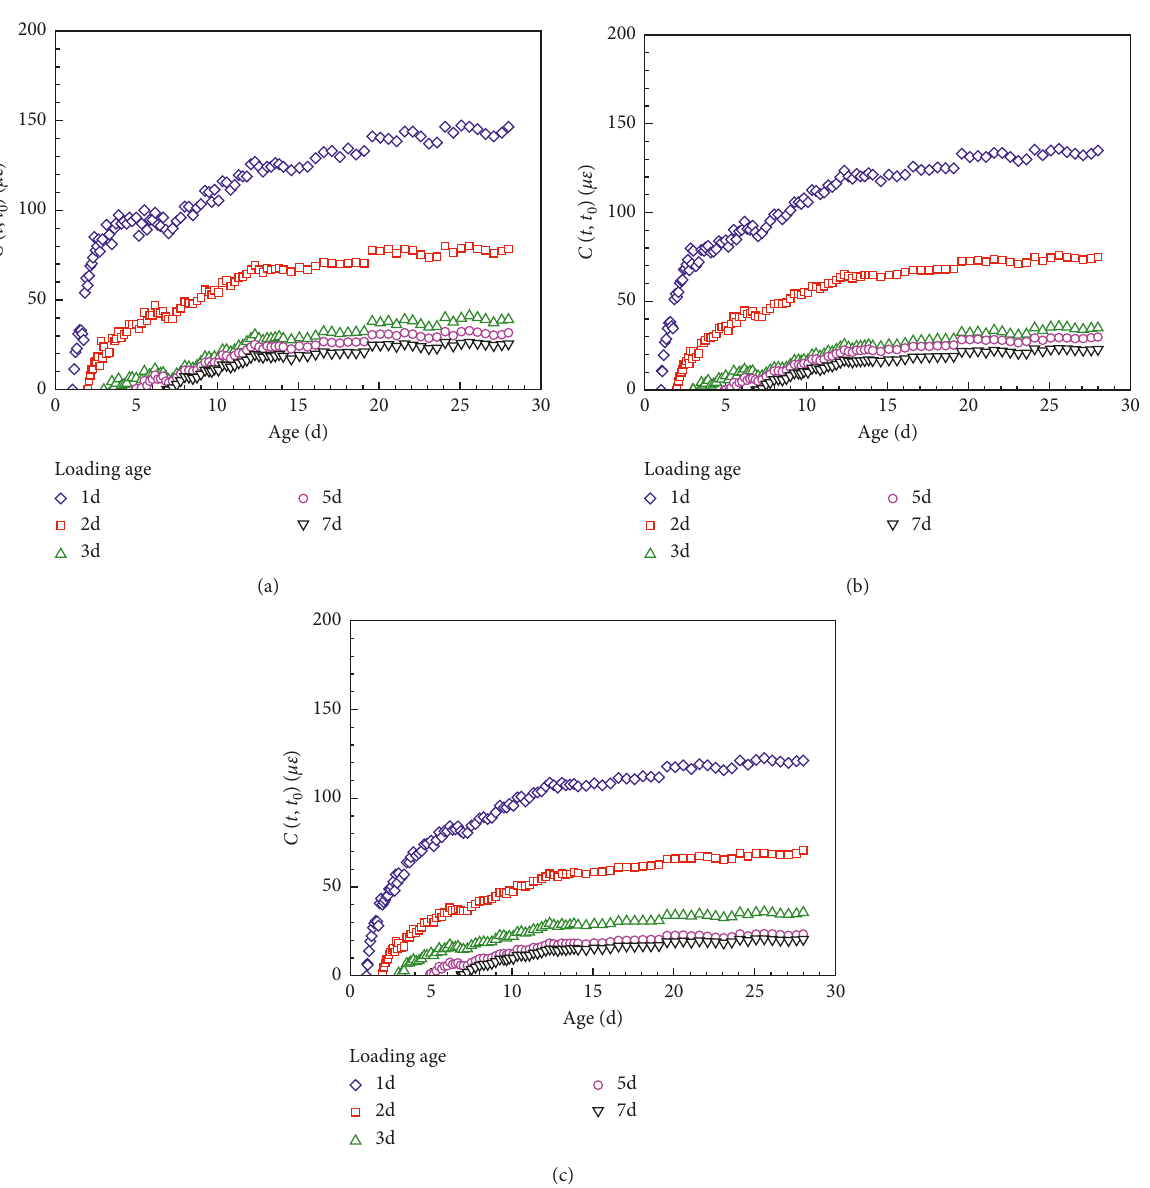
Figure 6: Specific creep of BS group at different loading ages. Stress/strength ratios: (a) 0.2, (b) 0.3, and (c)